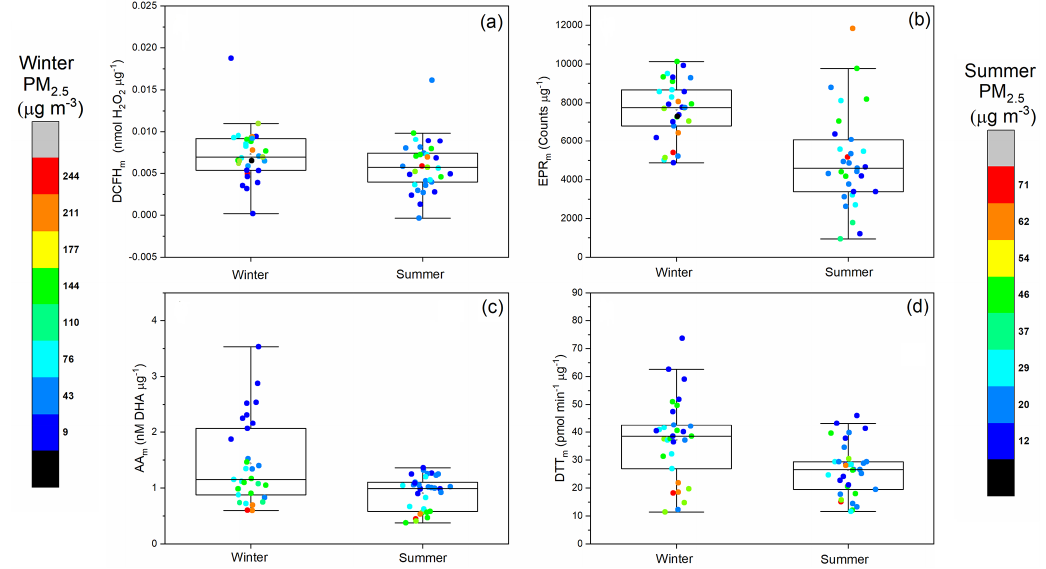
Figure 3. Summer and winter 24h averaged mass-normalised OP m (a) DCFH m (nmolH 2 O 2 µg − 1 ), (b) EPR m (countsµg − 1 ), (c) AA m (µMDHAµg − 1 ) and (d) DTT m (pmolmin − 1 µg − 1 ). Box plots indicate the median, 25% and 75% percentiles, and the data range. Data points are colour coded with respect to the 24h average PM 2 . 5 mass (µgm − 3 ), with a separate colour scale for winter and summer PM 2 . 5 masses given the difference in total PM 2 . 5 masses observed between the